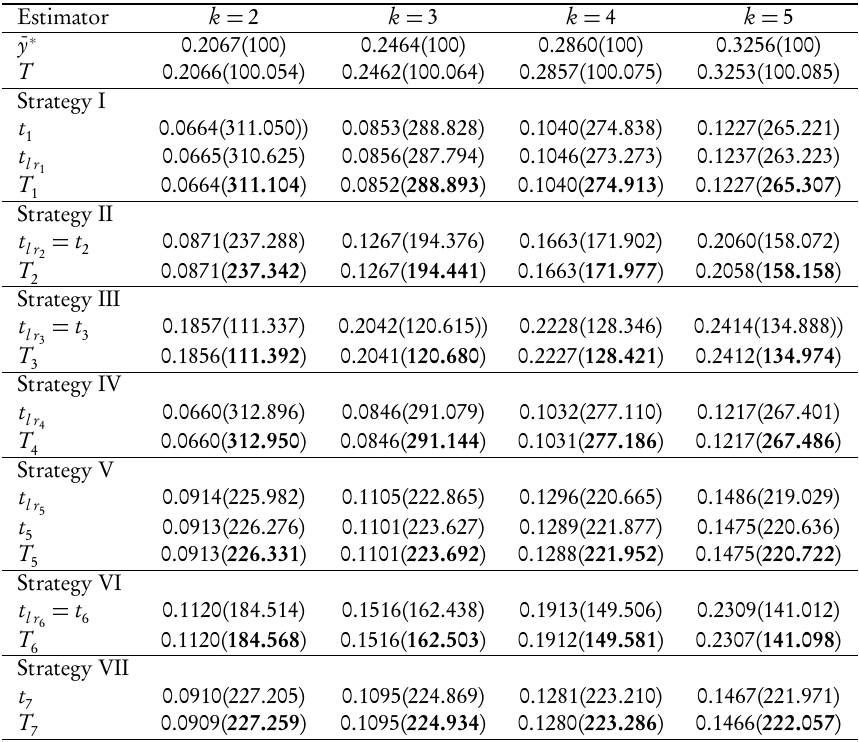
MSE and PRE of the existing estimators and proposed estimators for the second